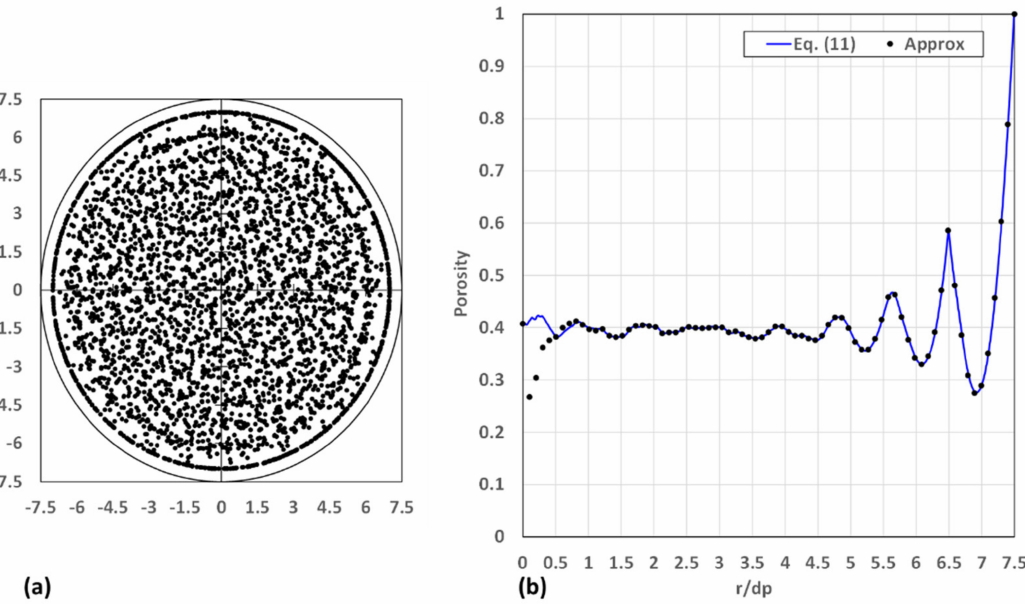
Figure 10. ( a ) Positions of centres of the spheres and ( b ) the radial variations in porosity based on Equation (11) and the approximate expression for D / d p =